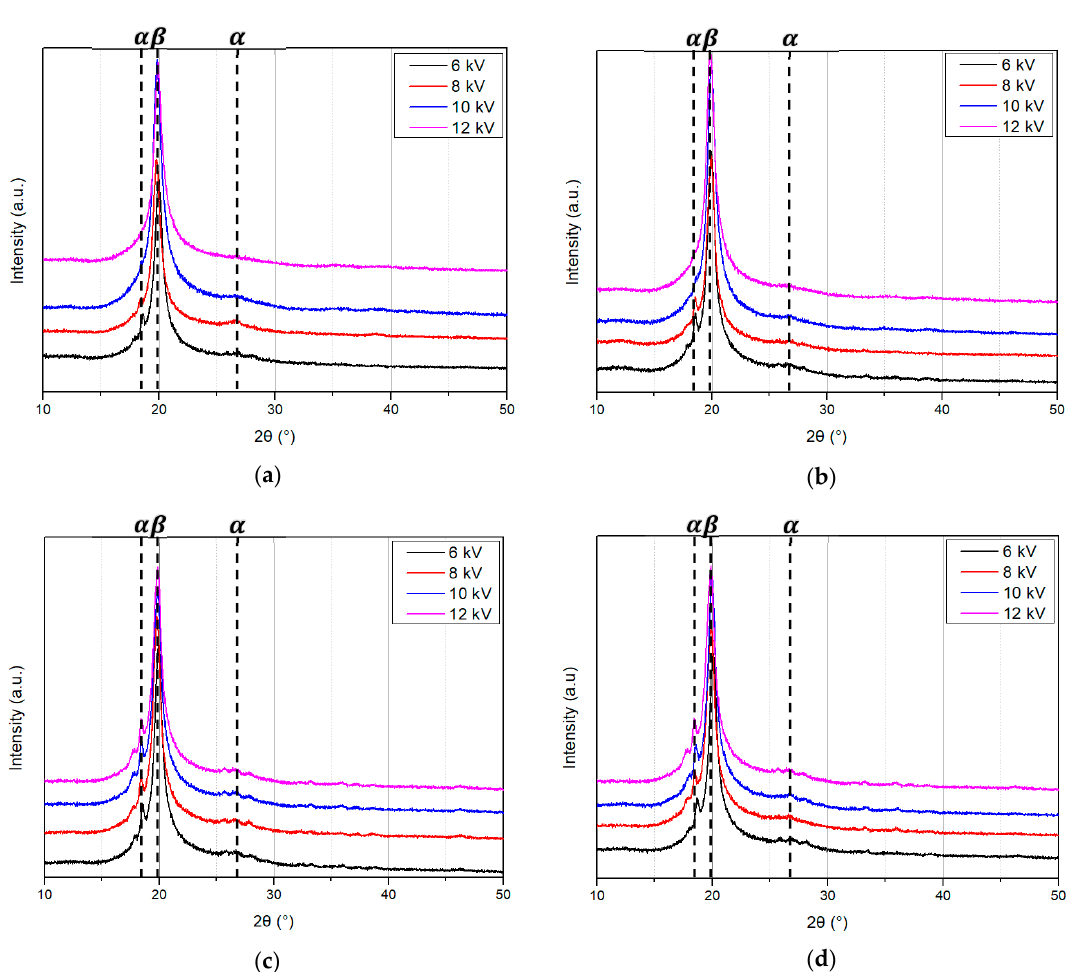
Figure 12. XRD patterns of the poled PVDF/PAR composites at drawing temperature of ( a ) 70, ( b ) 90, ( c ) 110, and ( d ) 130 °C.